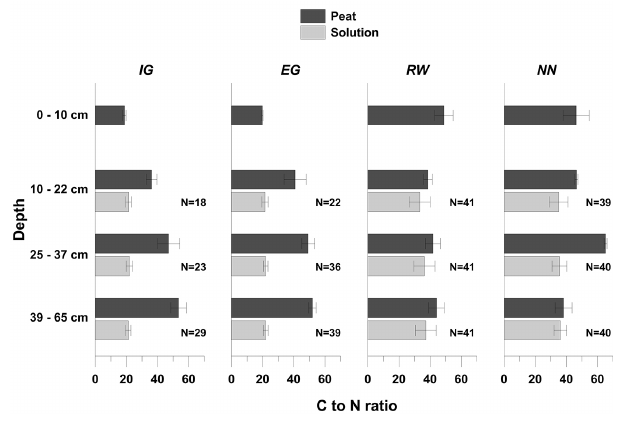
Fig. 9. DOC to DON ratio of the soil solution and C to N ratio of the uppermost and the corresponding peat layers ( n = 3). Bulk solution means of 3 chambers (10–22cm and 25–37cm) and 6 chambers (39–65cm) over the complete sampling period (February 2012– February